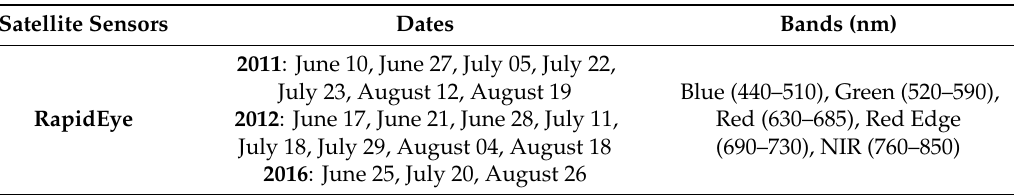
Table 2. Summary of satellite images and their characteristics.